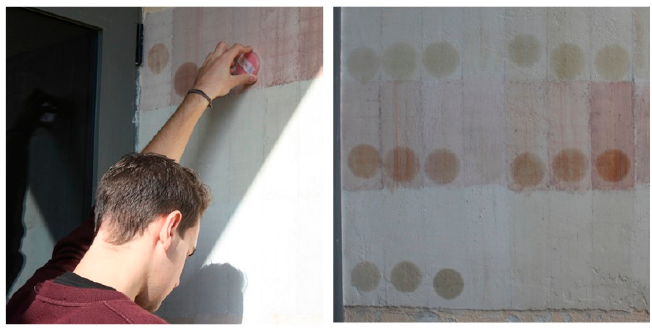
Figure 6. Abrasion test.